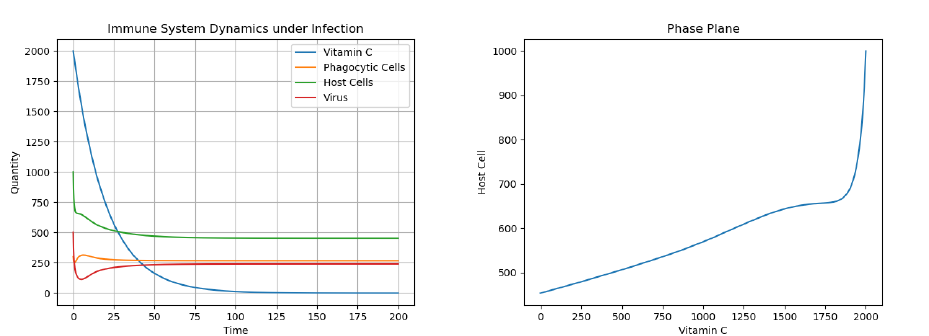
Figure 9. Dynamics under Frustrated Phagocytosis with Single Vitamin C Dose